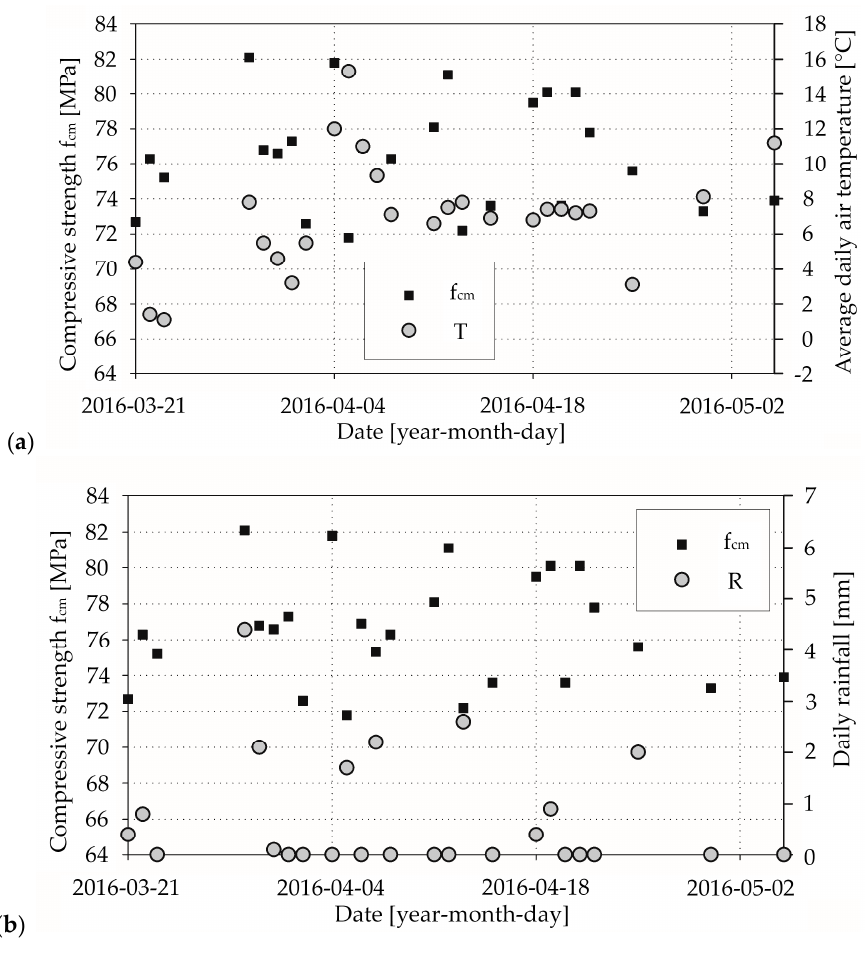
Figure 4. Laboratory test results for concrete mix CM_B type: ( a ) compressive strength and corresponding average daily air temperatures; ( b ) compressive strength and corresponding daily rainfall. Table 4. Compressive strength of concrete mix type.